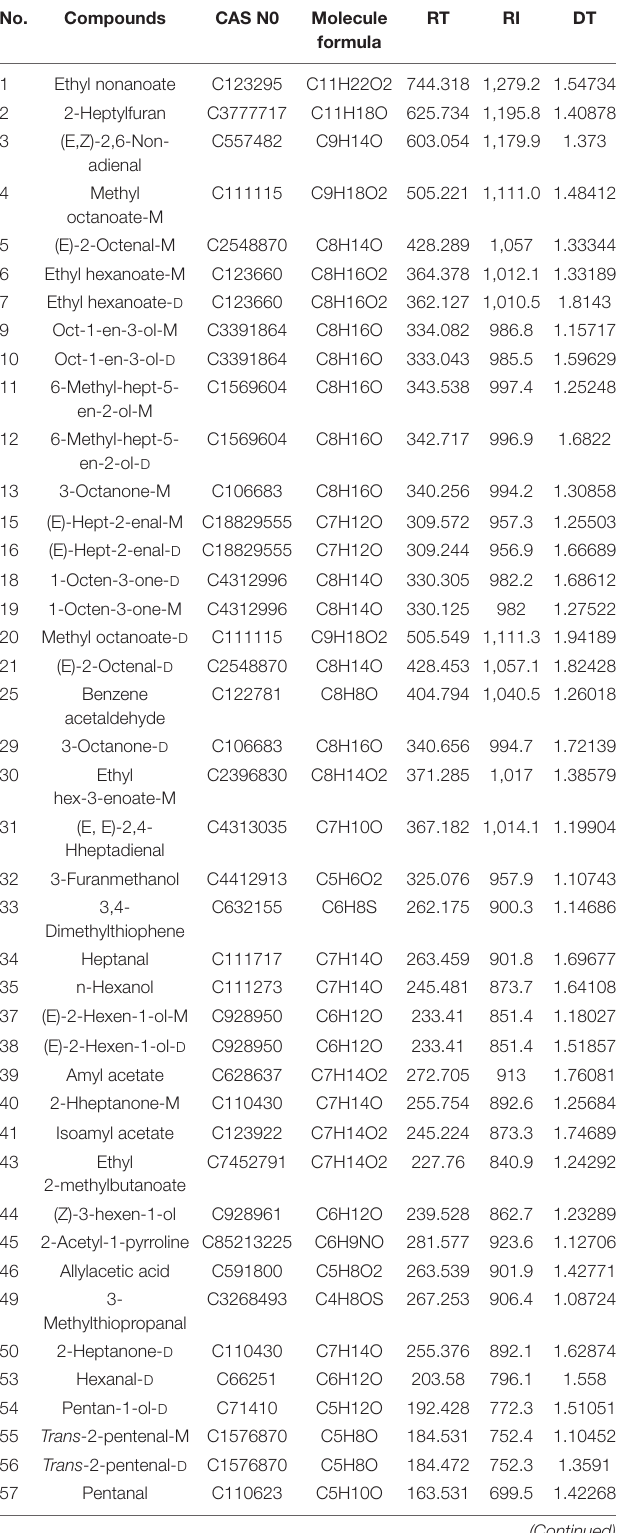
TABLE 2 | Gas chromatography-ion mobility spectrometry (GC-IMS) integration parameters of the volatile compounds detected in the 30 vegetable soybean cultivars used in the present